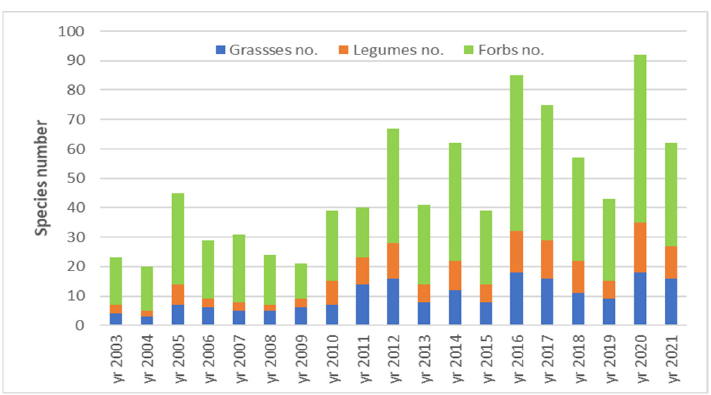
Figure 7. Dynamics of floristic composition of the main functional groups as species number (no.), during 2003–2021 period in ex-arable grassland from Gr ă dinari.